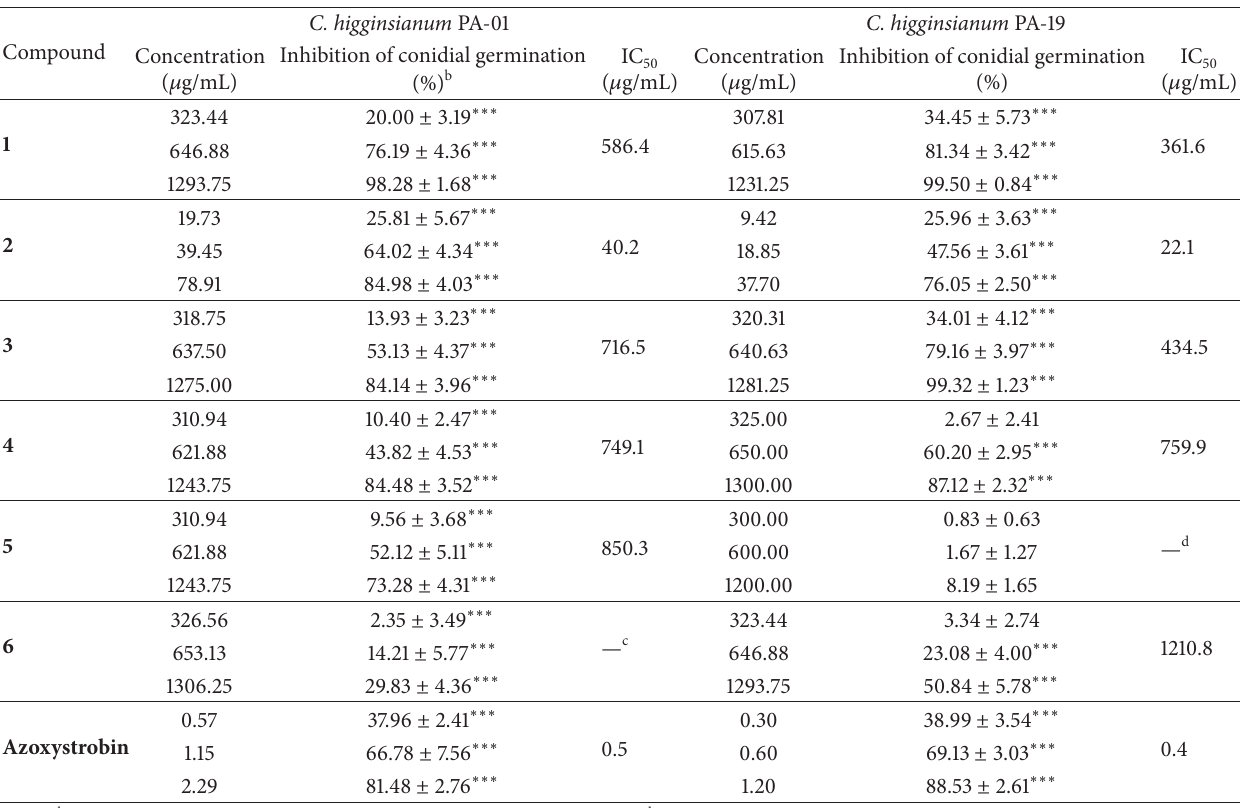
Table 5: Antifungal activity of indicator compounds a .